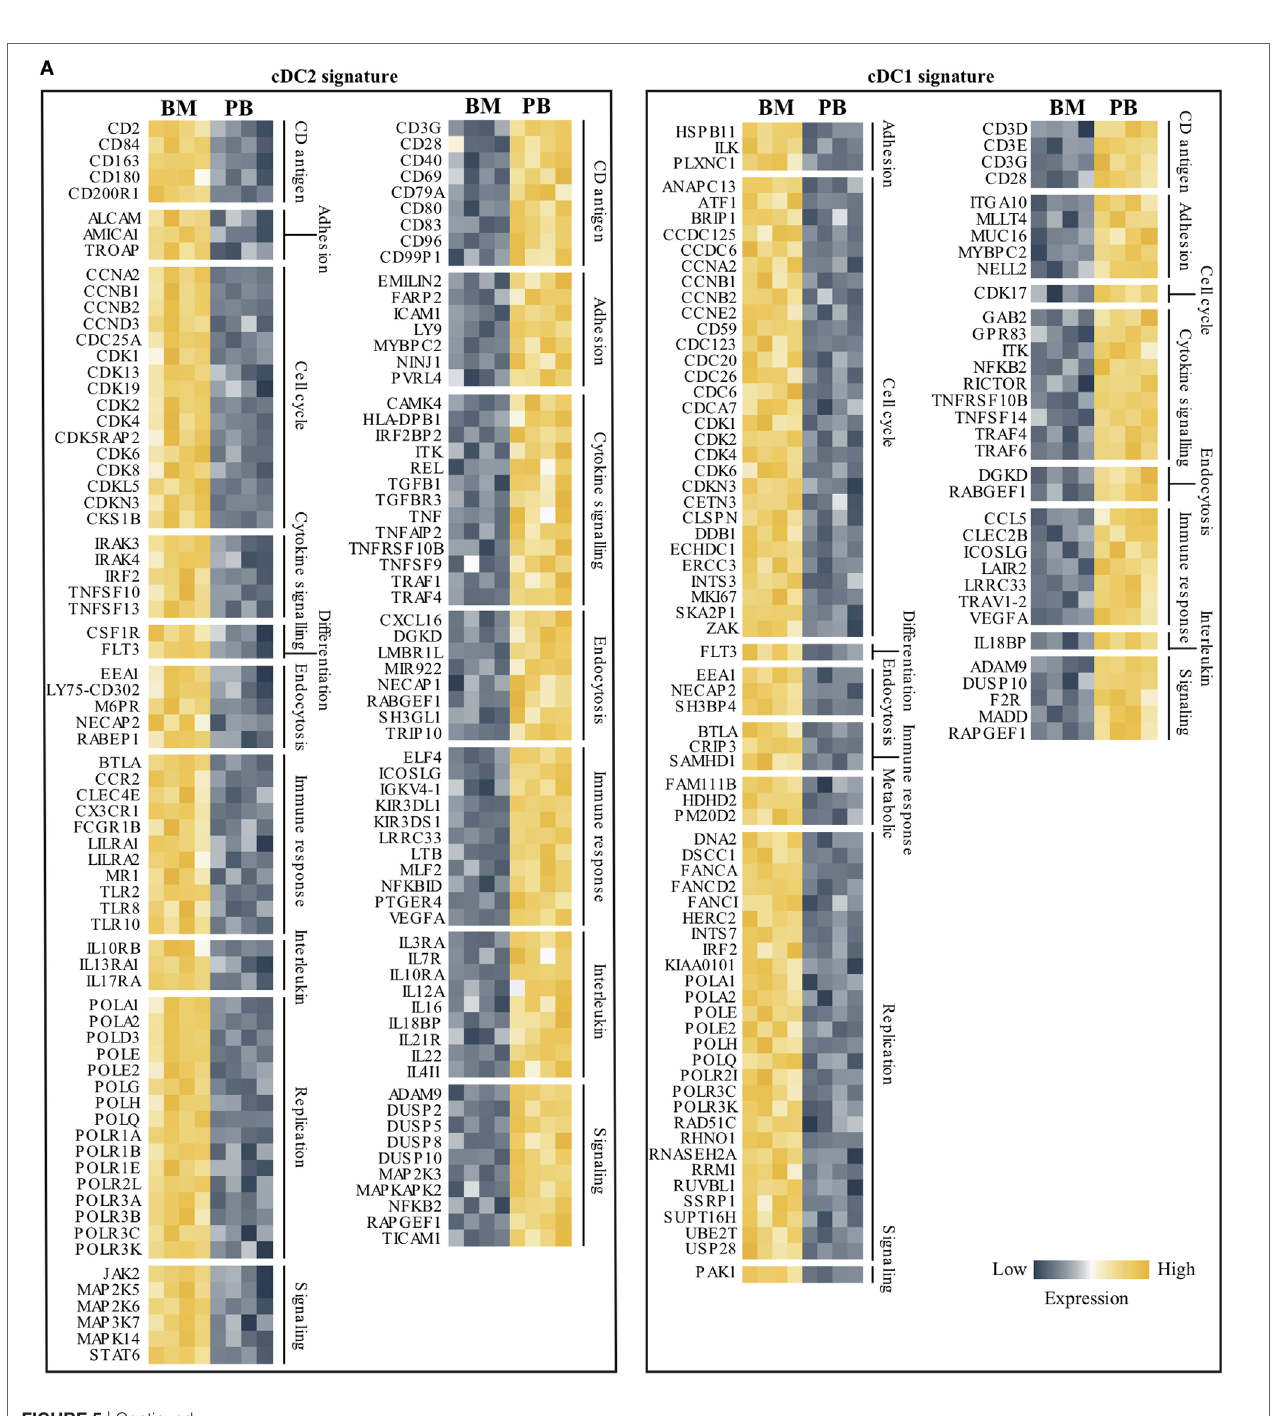
FigUre 4 | Transcriptomic comparison between cell subsets of the bone marrow (BM) vs the peripheral blood (PB) compartment. Gene expression profiles were compared between the BM and PB for each individual cell subset. (a) Number of differentially expressed transcripts found between the two different compartments (e.g., slan + in BM vs slan + in PB). Differentially expressed genes (DEGs) were clustered per row by using z-scores for each transcript, thereby reflecting relative expression levels. Heat maps for each individual subset are shown. For each cell subset, a pathway enrichment analysis was performed in which all DEGs were used that were over-expressed in BM (B) or over-expressed in PB (c) . Top 10 enriched biological processes for both compartments and each individual subset are shown. (D) Gene set enrichment analysis for BM- and PB-derived cell subsets. The top 10 of enriched KEGG pathways are shown together with four selected enrichment plots. Abbreviations: FDR, false discovery rate; GO, gene ontology; ID, identification; NES, normalized enrichment